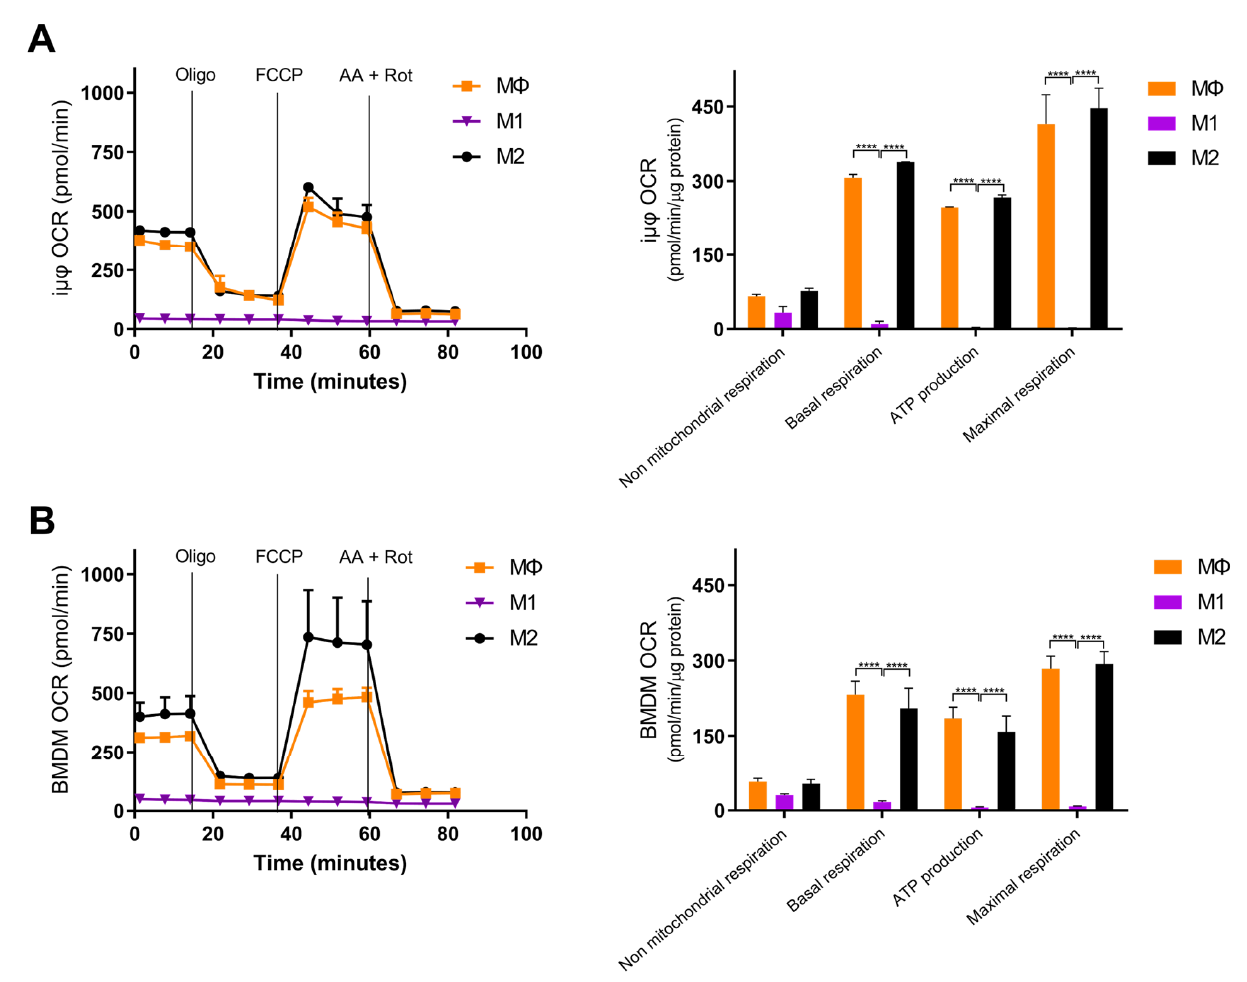
Figure 4. Bioenergetics are similar in M1- and M2-stimulated i µ Φ and BMDM macrophages. i µ Φ ( n = 3) ( A ) and BMDMs ( n = 3) ( B ) were seeded in Seahorse plates and stimulated for 24 h to yield resting (M Φ )-, M1- and M2-polarized macrophages. During extracellular flux analysis, cells were sequentially treated with oligomycin (1.5 µ M), FCCP (1.6 µ M), and antimycin A plus rotenone (AA + ROT, 2.5 µ M and 1.5 µ M, respectively) to assess the OXPHOS parameters from the Oxygen Consumption Rate (OCR) levels (right panels, see Materials and Methods for details). FCCP uncouples mitochondrial respiration and the corresponding OCR measurements yield data about the maximal respiratory capacity. Rotenone and antimycin A block mitochondrial complex I and III, and the residual OCR represents non-mitochondrial oxygen consumption. Data are means ± SEM. **** p <